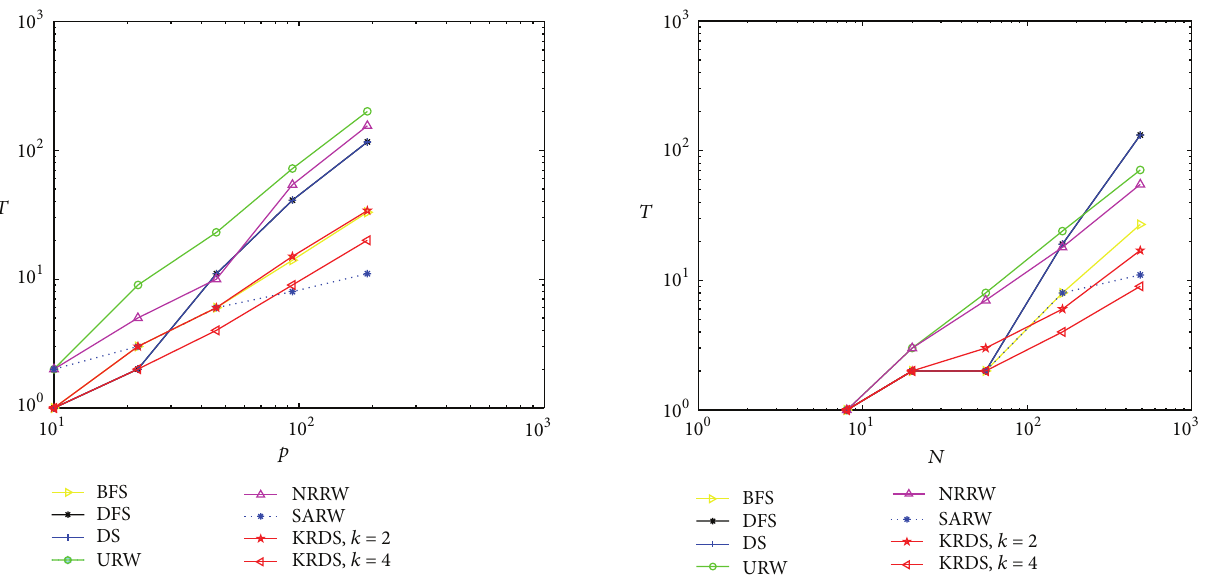
Figure 11: Plot of the average number 𝑇 of search steps versus the network size 𝑁 of the CUB in the log-log